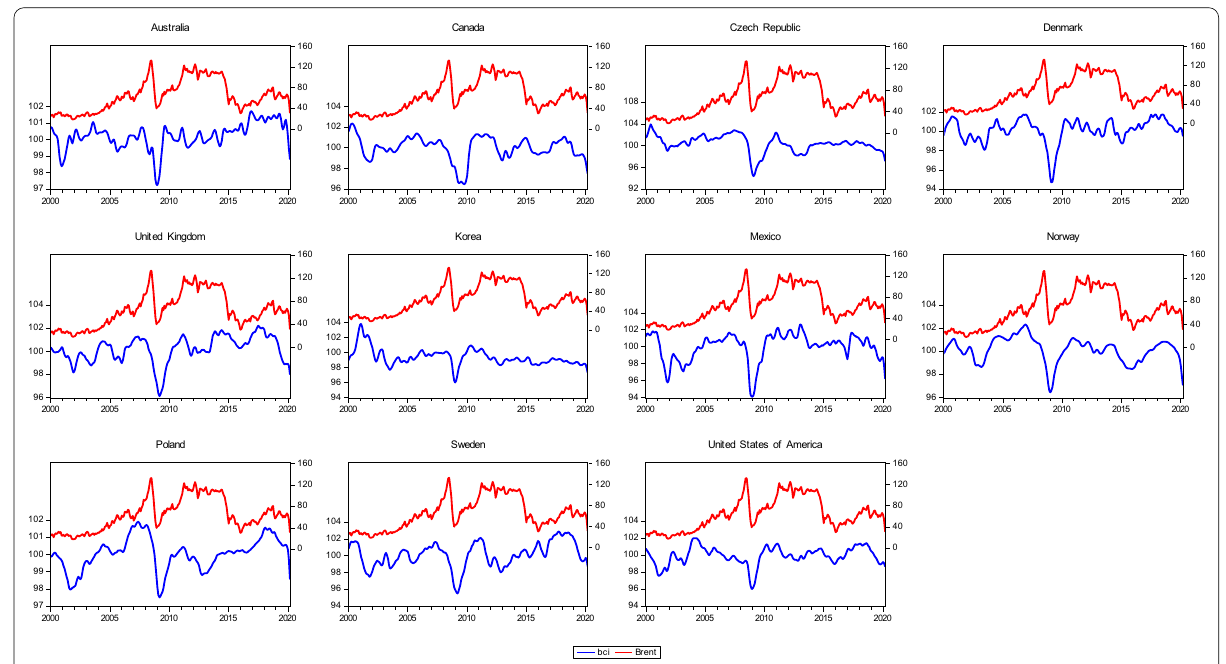
Fig. 2 Trends in business confidence and global oil price in the non-Eurozone